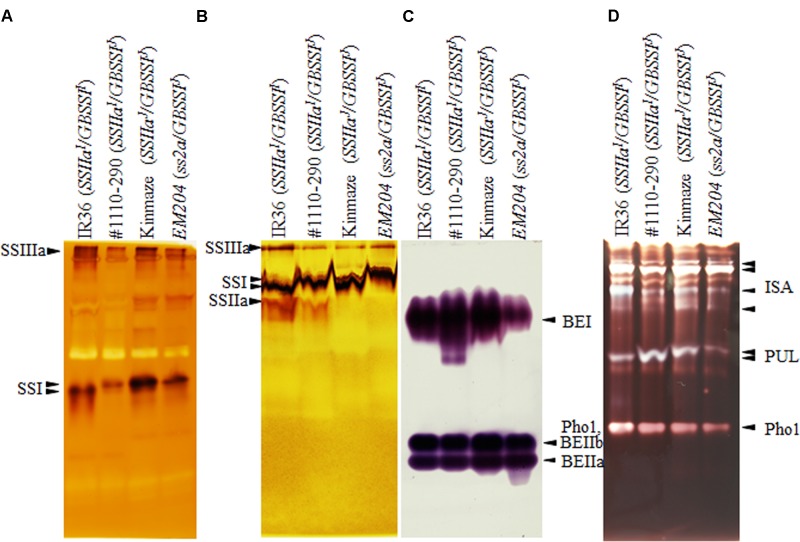
Pleiotropic effects on starch biosynthetic enzymes revealed by native-PAGE/activity staining. (A) Starch synthase (SS) I and SSIIIa activity was detected using glycogen as primer. It is noted that SSI derived from Indica rice migrate faster than that of japonica rice (Chen and Bao, 2016; Itoh et al., 2017). (B) SSIIa activity was detected using maize amylopectin as primer; reaction was performed at pH 10 to minimize hydrolase activity (see Section “Materials and Methods”). (C) Branching enzyme (BE) activity. BEIIb and Phosphorylase 1 (Pho1) activity bands were overlapped. (D) Debranching enzyme (DBE) activity. Each isozyme labeled with arrowheads has been identified with corresponding mutant rice lines. IR36, indica rice cultivar, SSIIaI/GBSSII; #1110-290, SSIIaI/GBSSIJ; Kinmaze, japonica rice cultivar, SSIIaJ/GBSSIJ; EM204, ss2a/GBSSIJ.